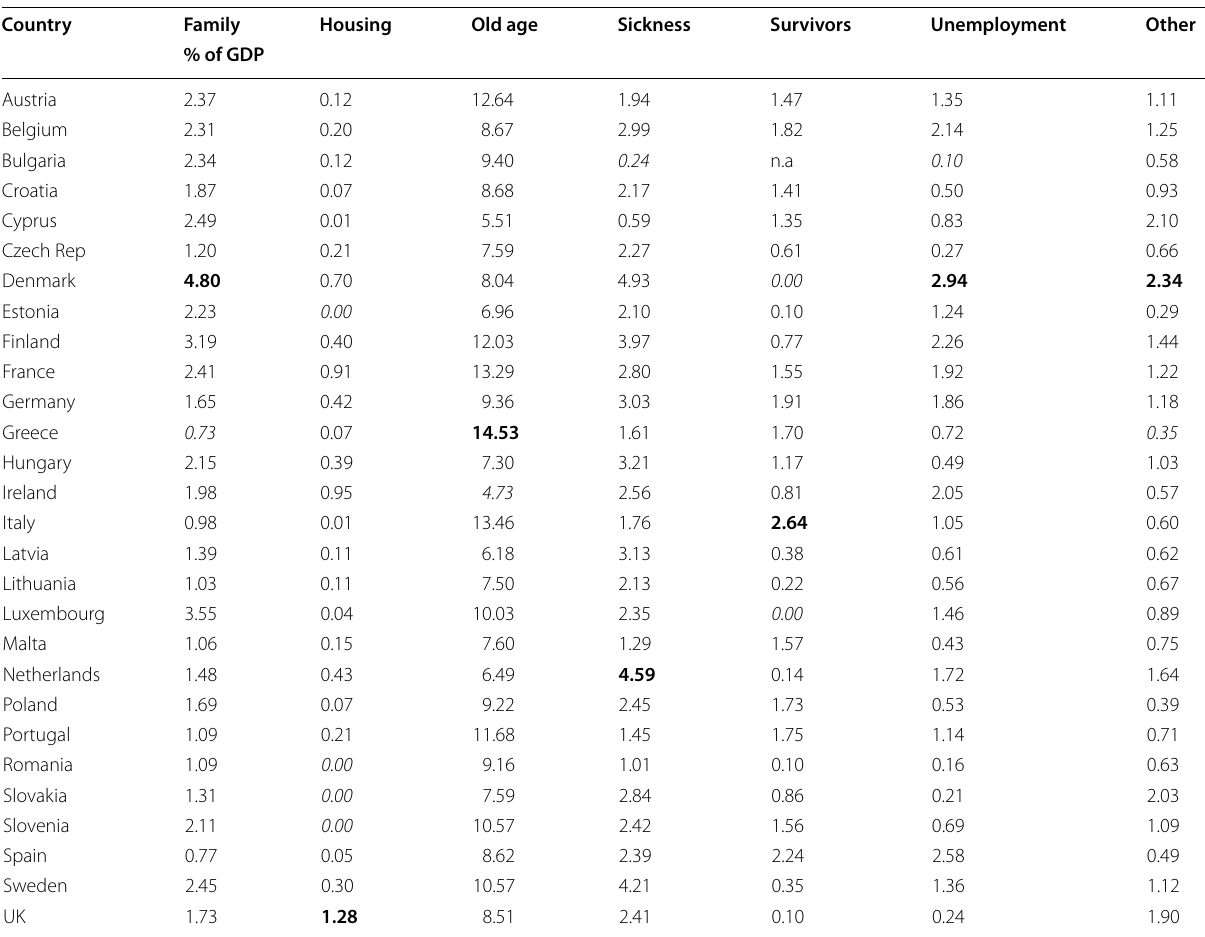
Maximum in bold, minimum in italics Source Own calculation on the basis of Eurostat data, access 17.10.2020